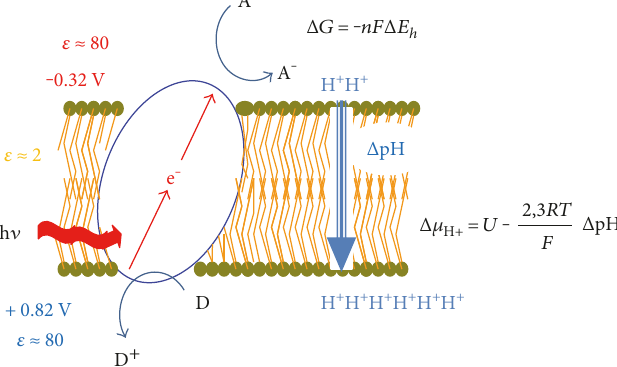
Figure 4: Schematic representation of connection of free energy of light (h ν ) to redox free energy of secondary donor (D + /D) and acceptor (A/A − ) redox systems and to the proton motive force (pmf, Δ μ explanation in the